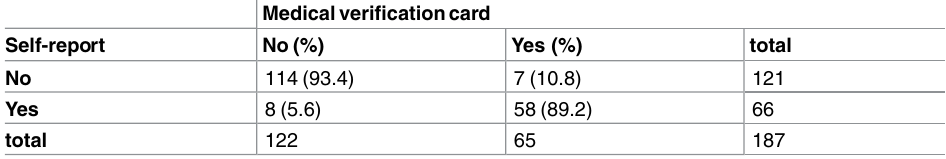
Table 2. Agreementbetweenself-report and medical verification cards for completinga seriesof vac- cinations(n = 187).